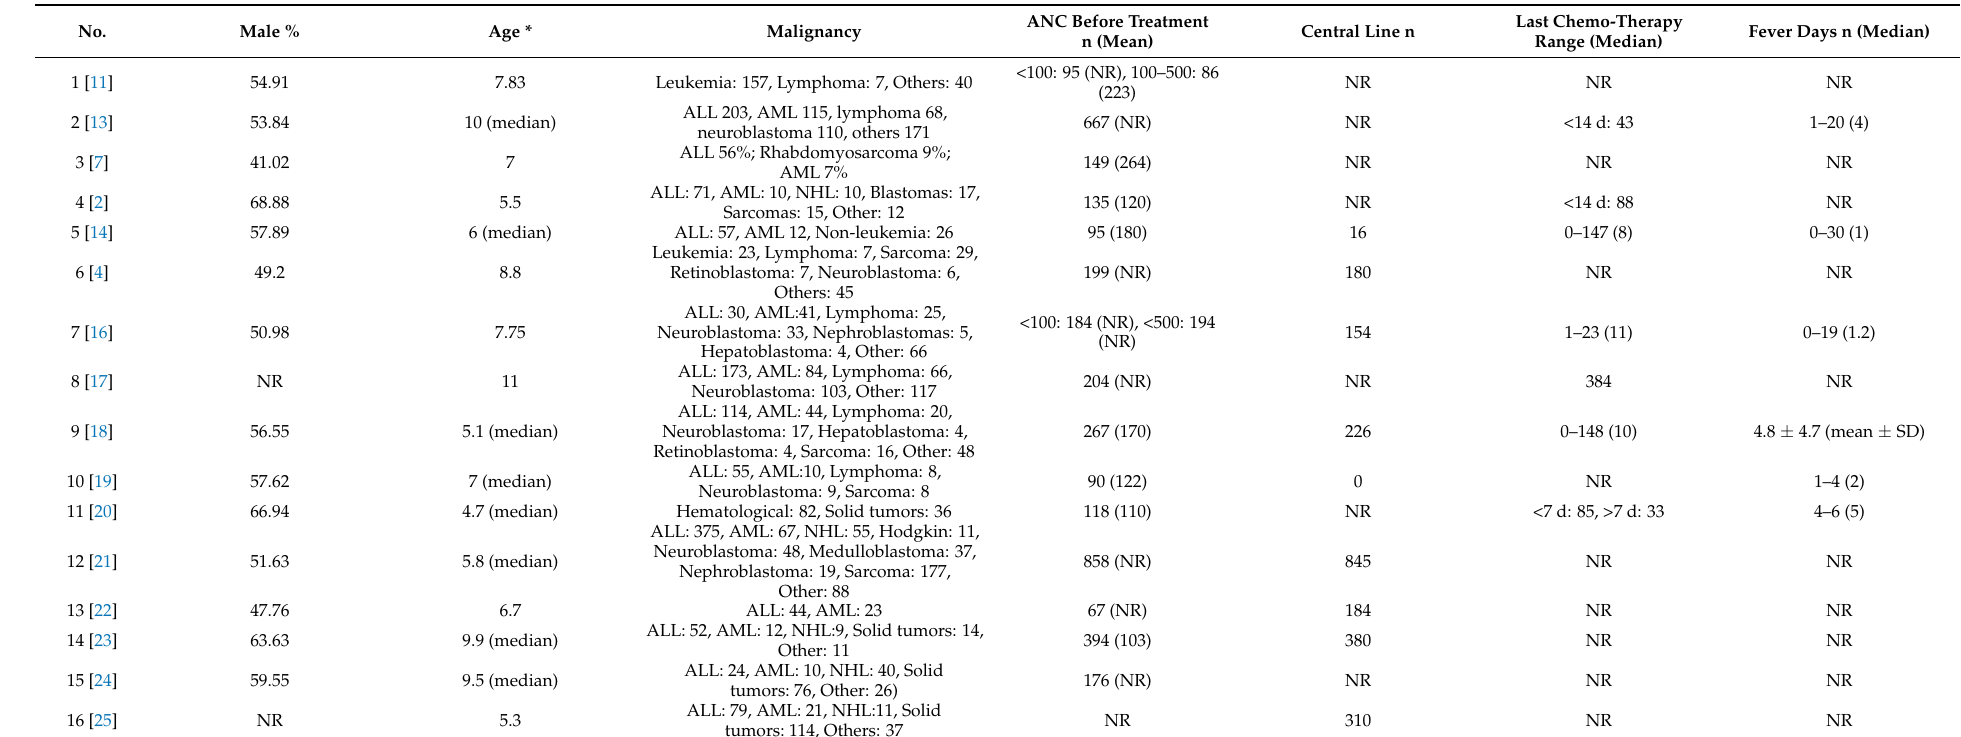
Table 2. Demographic data extracted from the